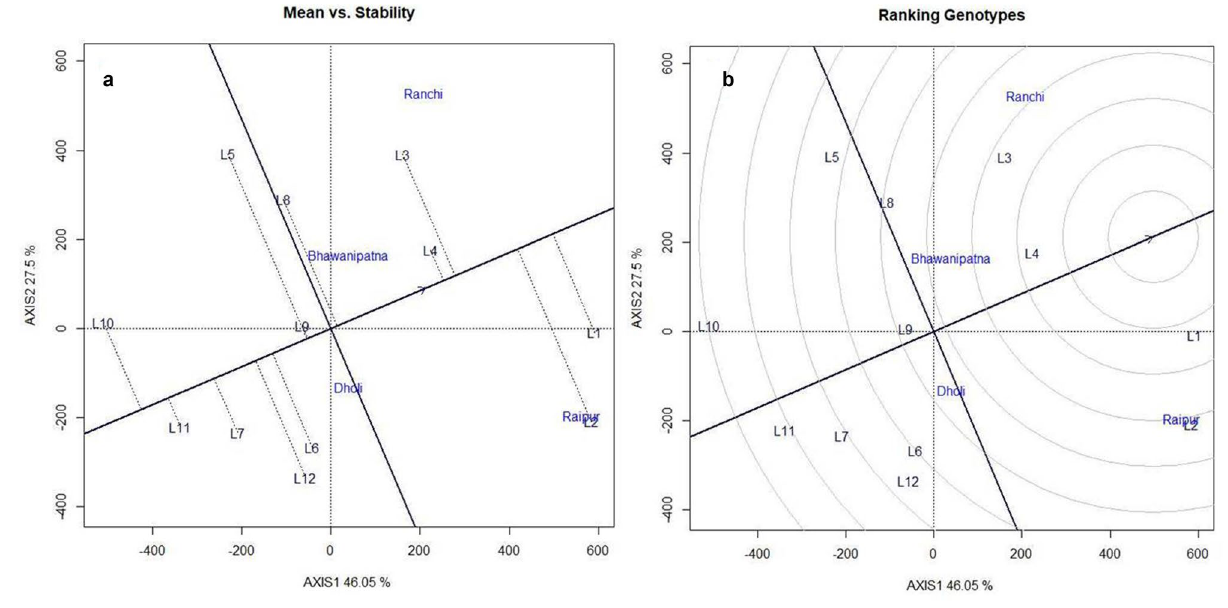
Figure 5. GGE Biplot analysis of genotypes evaluated in Eastern Zone: ( a ) Mean vs Stability analysis, ( b )- Ranking of genotypes based on ideal genotype: L1-RAC 11–07, L2-NRC 128, L3-AMS 2014–1, L4- NRC 136, L5- MACS 1493, L6- RSC 11–03, L7-NRCSL 1, L8-NRC 132, L9-NRC 137, L10-JS 335, L11-RKS 18 and L12- JS 97–52.